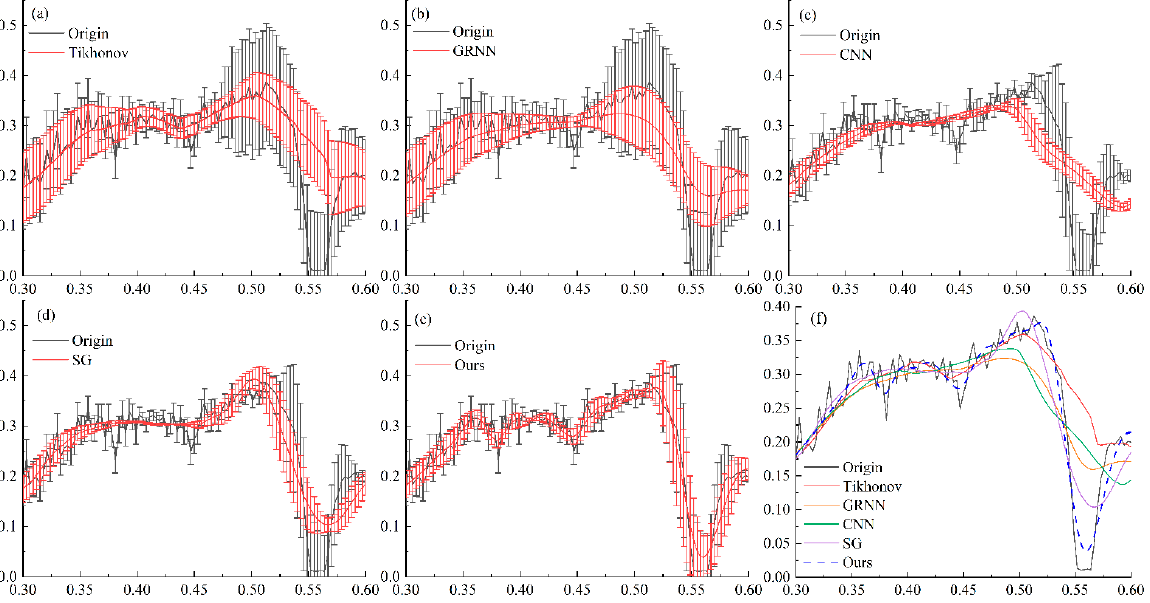
Figure 9. The restored effect of region A. ( a – e ) Comparison of real THz spectra with Tikhonov, GRNN, CNN, SG, and the proposed method, respectively. The error bars are calculated from the standard deviation. ( f ) The denoising effect without error bars.